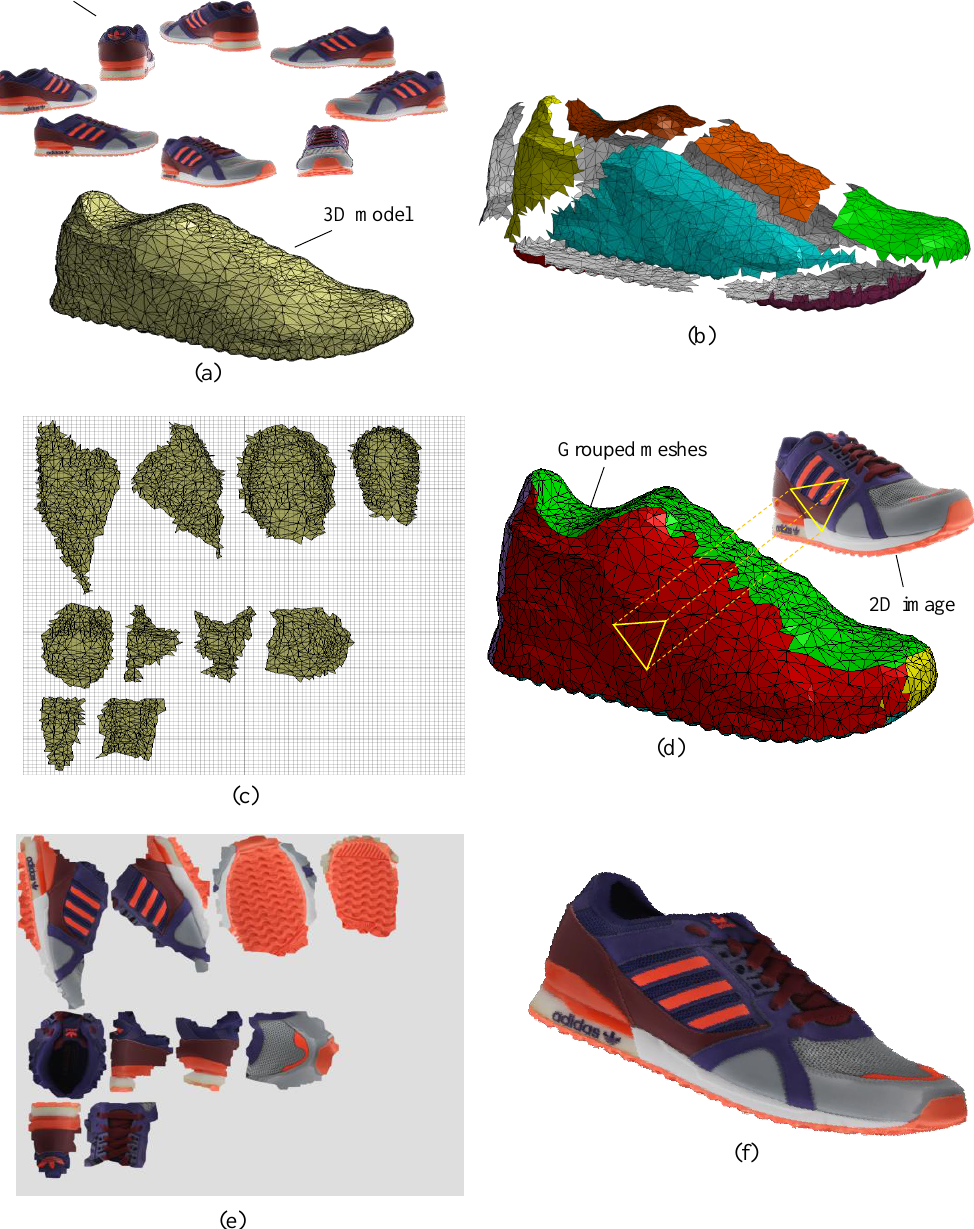
Figure 1. Overall flowchart of the proposed texture mapping method: ( a ) input data, ( b ) mesh partitioning, ( c ) mesh parameterization and packing, ( d ) texture transferring, ( e ) correction and optimization, and ( f ) output object file.